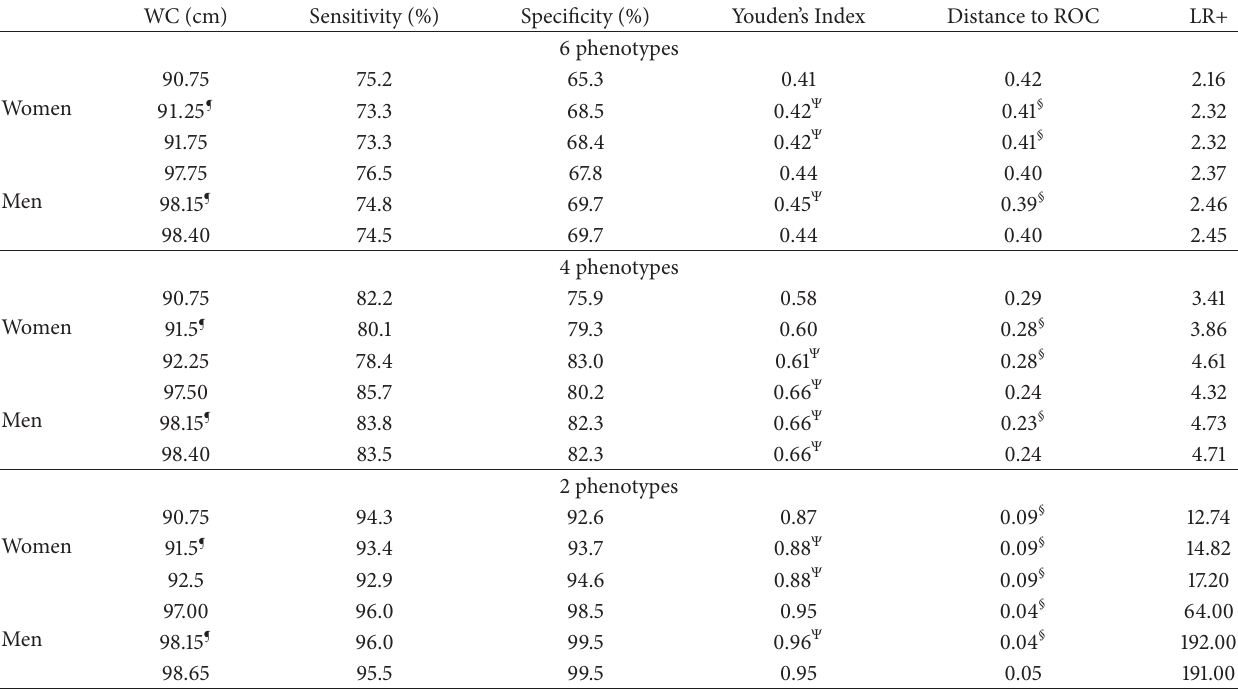
Table 7: Waist circumference cut-offs based on ROC Curves. Sensitivity, Specificity, Youden’s Index, Positive Likelihood, and Distance to the ROC Curve. Maracaibo City Metabolic Syndrome Prevalence Syndrome, 2013.